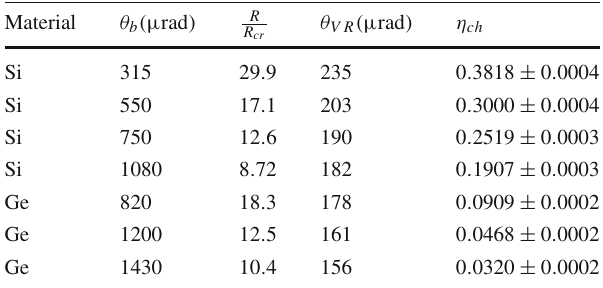
Table 2 Simulated Si and Ge crystal bending radia, angles and chan- neling efficiency Material